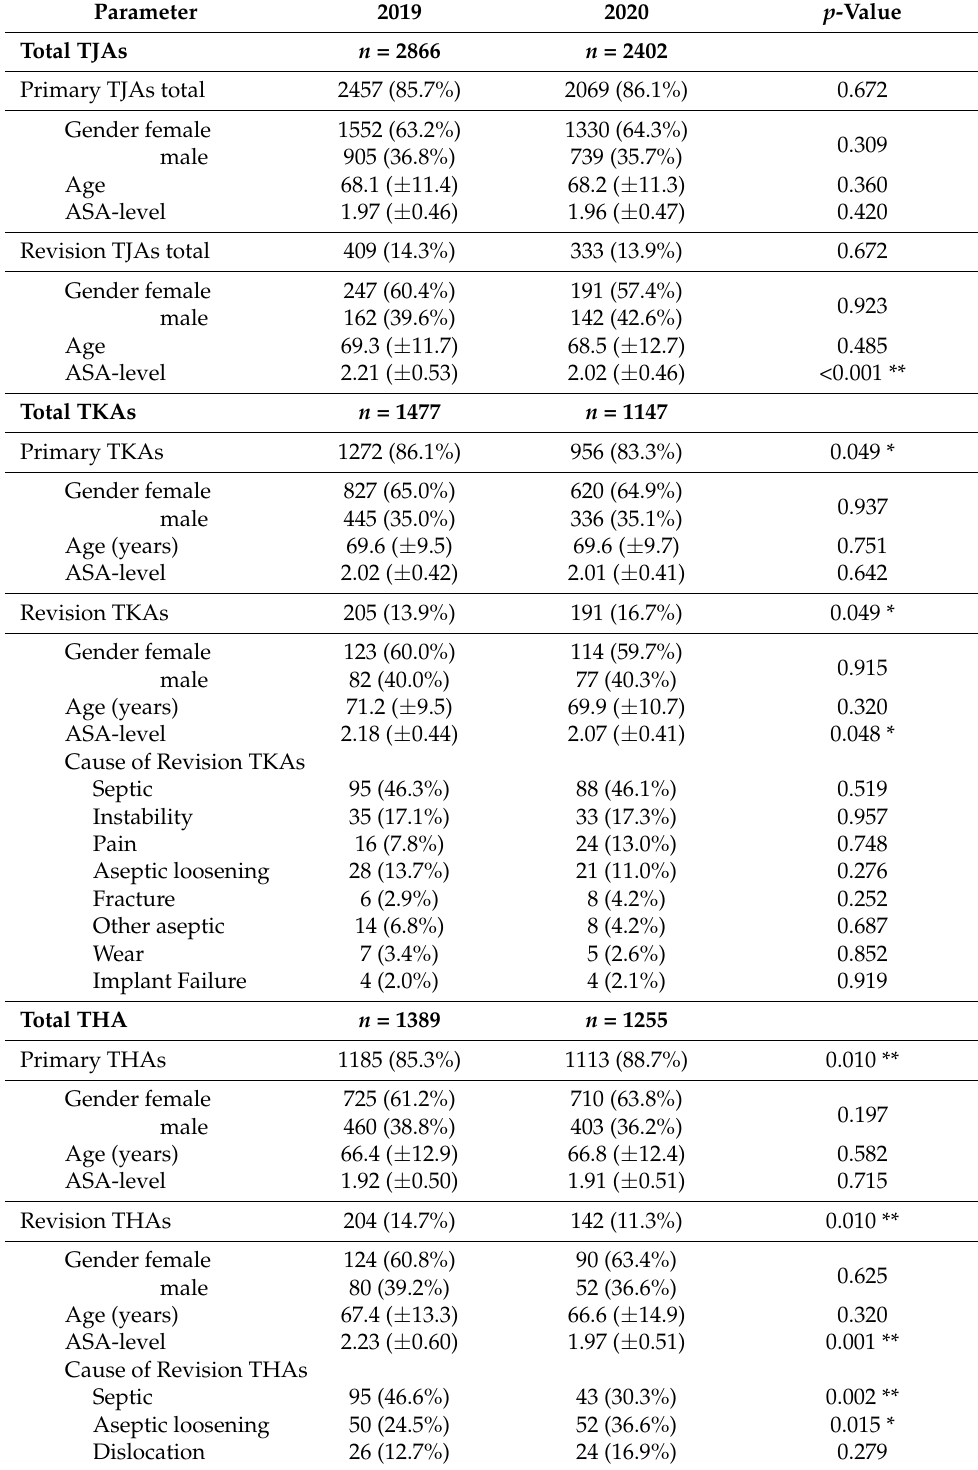
Table 1. Characteristics of study relevant parameters for surgical procedures in 2019 and 2020 includ- ing gender, age, and American Society of Anaesthesiologists (ASA)-level. Frequencies and column percentage of distribution according occurrence of septic, aseptic loosening, Instability/Dislocation, fracture, other septic conditions, abrasion, pain, implant failure, and leg length difference (LLD); ** p ≤ 0.01, * p ≤